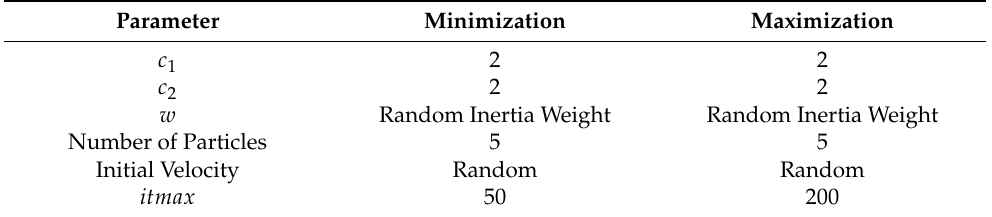
Table 1. PSO initial configuration